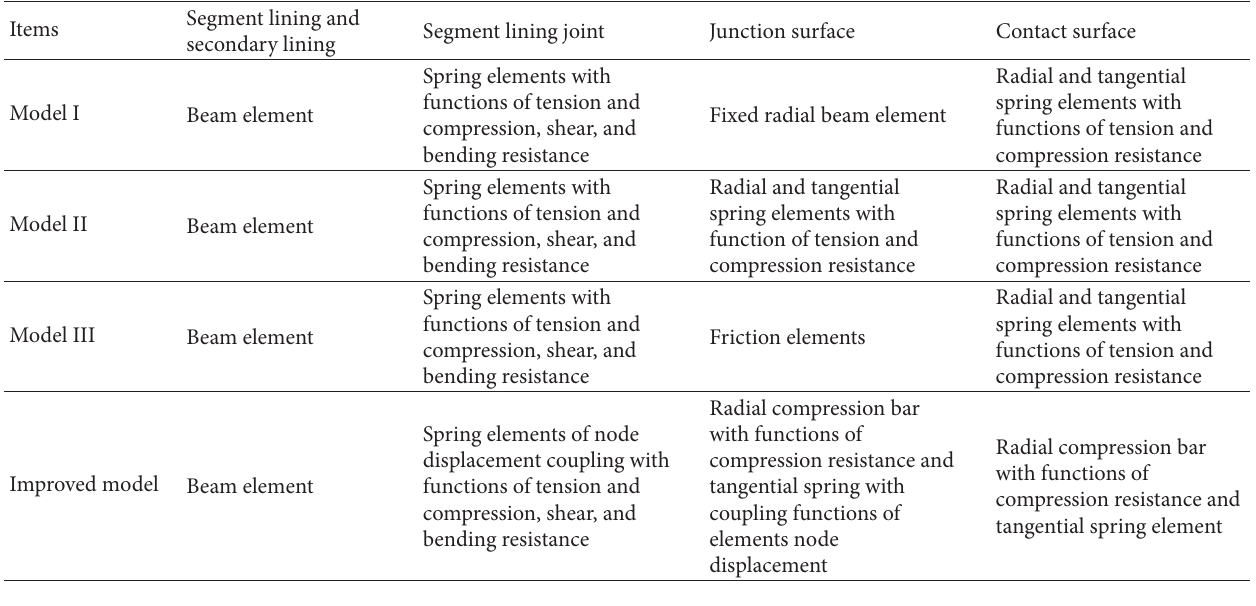
Table 1: Comparison of elements between improved model and existing models.